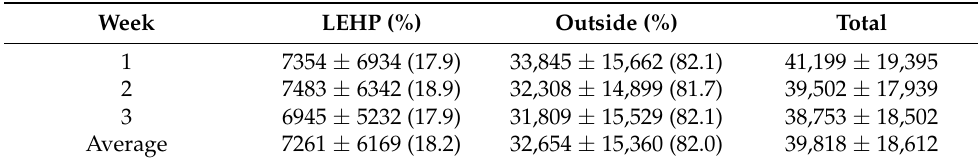
Table 1. Mean and standard deviation of the steps per week achieved in La Crosse Exercise and Health Program (LEHP) and